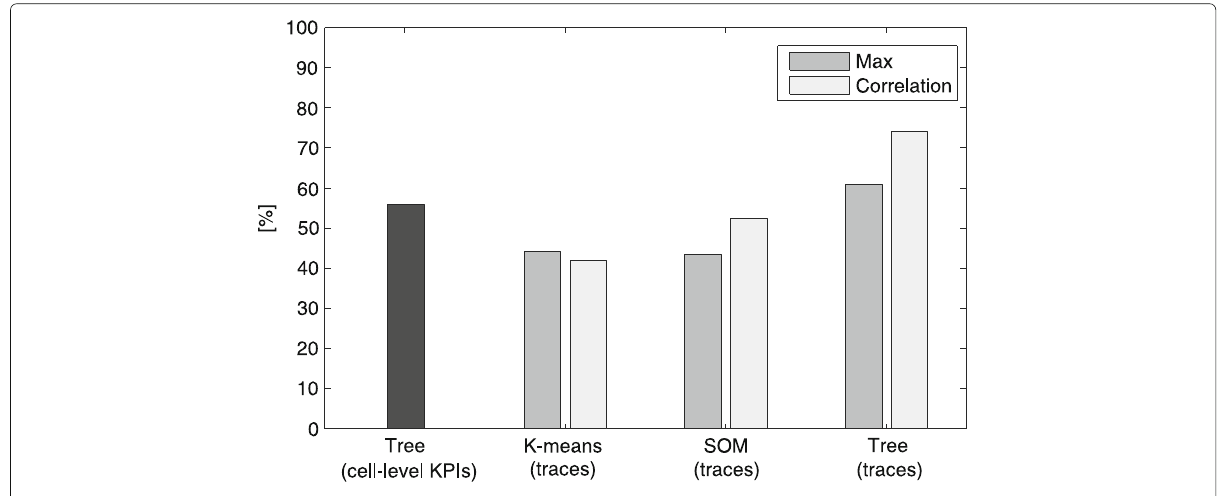
Fig. 9 Global diagnosis success rate for cell diagnosis